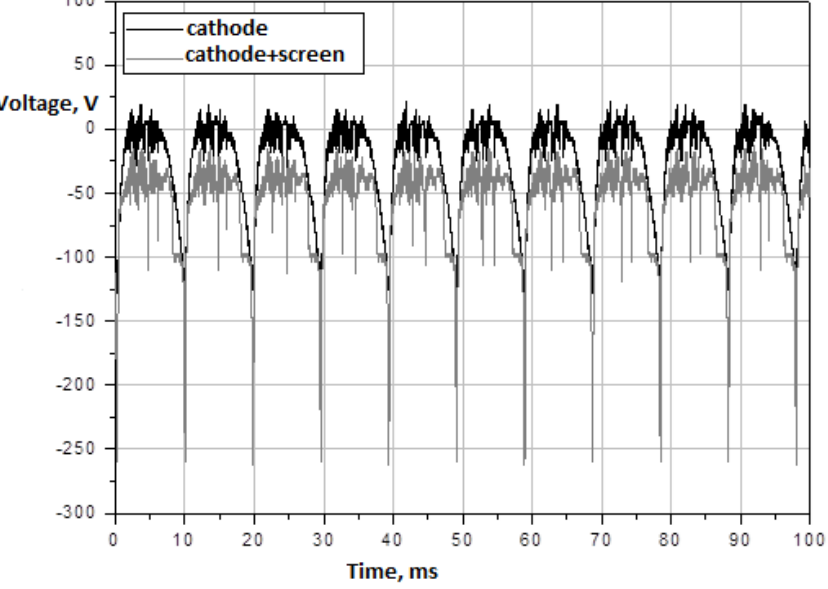
Figure 13. Comparison of the voltage waveforms at the screened sample (bottom) and the unscreened sample (top). Recorded with a time base of 10 ms.